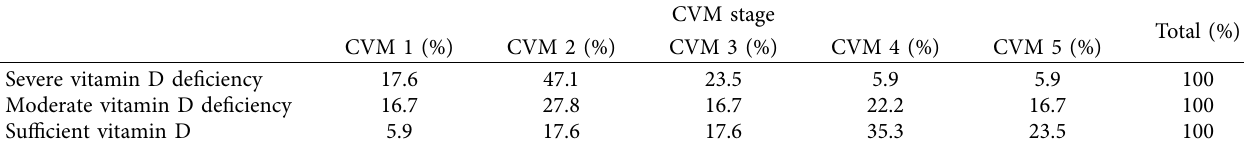
Table 1: CVM stages by vitamin D (25(OH)D) level category among the study groups.